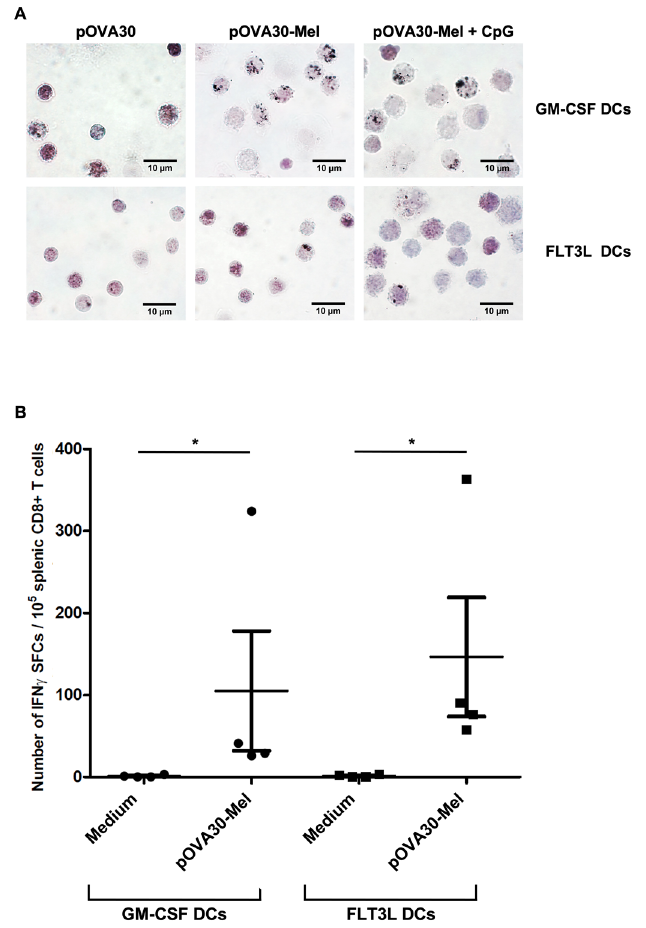
Figure 1. Dendritic cells efficiently phagocytize melanin–peptide nanoaggregates and cross-present the antigen to T lymphocyte. ( A ) Fontana-Masson and hematoxylin–eosin staining of dendritic cells derived from bone marrow cells and cultivated with GM-CSF (GM-CSF DCs) or FLT3L. Low doses of GM-CSF (FLT3L DCs) after 24 h incubation with pOVA30-Mel, pOVA30-Mel, and CpG, or pOVA30 (as negative control). Concentrations used for the different solutions: melanin at 4 μ g/mL, pOVA30 at 2 μ g/mL, CpG at 1 μ g/mL. Experiments were performed twice for each type of cells, and images were taken using an Eclipse 600 Nikon microscope with 100× objective. Intracellular mela- nin, colored by Fontana-Masson staining, appears as dark dots. The most representative images were chosen for each cell type and condition. ( B ) CD8 + splenic T cells isolated from mice vaccinated with [pOVA30-Mel + CpG] (7 days earlier) were co-cultured with bone marrow-derived dendritic cells (GM-CSF or FLT3L DCs) in the presence or absence (medium) of pOVA30-Mel nanoaggregates.